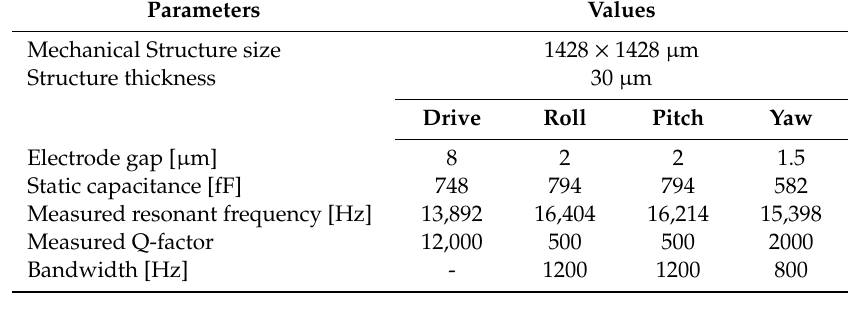
Figure 1. Schematic of the designed single drive multi-axis gyroscope. Table 1. Design parameters of single drive multi-axis gyroscope.